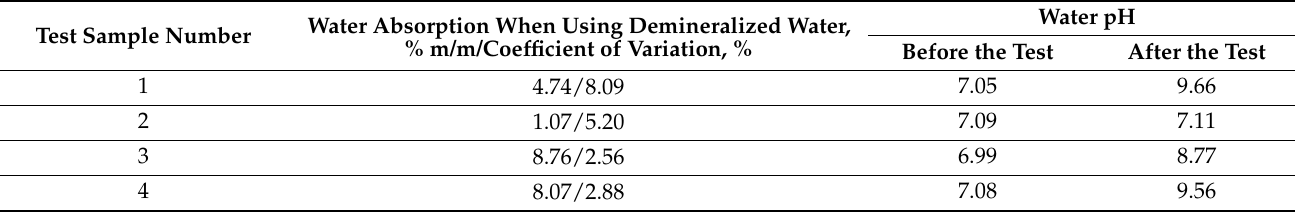
Table 2. Results of demineralized water absorption test of polymer modified bituminous thick coatings. Test Sample Number